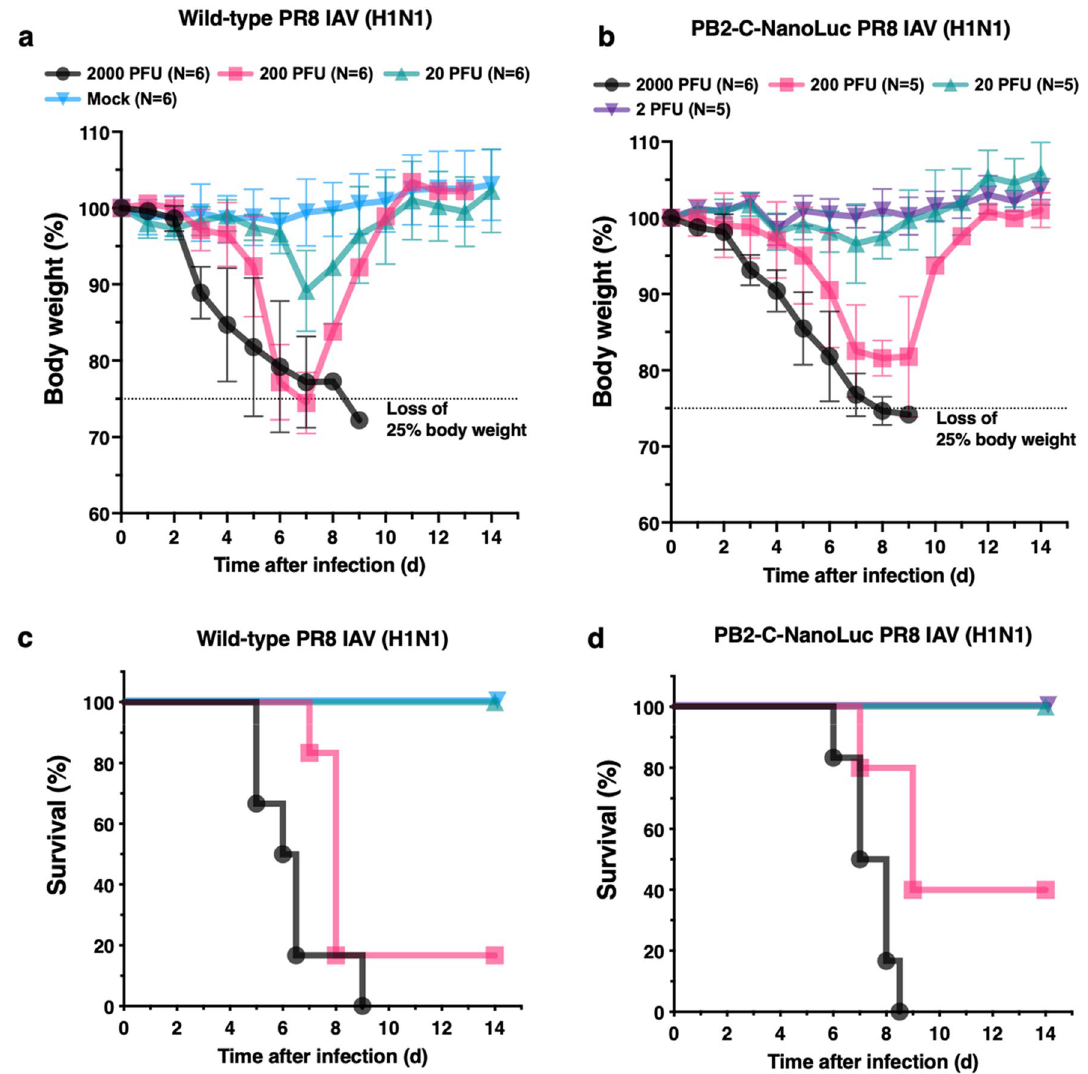
Figure 5. Virulence of wild-type and PB2-C-NanoLuc PR8 IAVs in mice. Female C57BL/6 mice aged 6 to 8 week were infected intranasally with wild-type or PB2-C-NanoLuc PR8 IAV at various doses or no virus (mock) in sterile PBS and observed for 14 days. Body weight reported as percentage of initial body weight (mean ± SD). ( a ) Body weight in cohorts of mice given mock infection or infected with wild-type PR8 IAV. Body weight decreased initially in infected mice but increased after 7 days in mice infected with 20 or 200 PFU of wild-type IAV that survived. ( b ) Body weight change in cohorts of mice infected with PB2-C-NanoLuc PR8 IAV. Body weight decreased initially in infected mice but increased in mice infected with 20 or 200 PFU of PB2-C-NanoLuc IAV that survived beyond 7 to 9 days. ( c ) Survival in mice given mock infection or infected with wild-type PR8 IAV; 5 of 6 mice infected with 200 PFU (83%) died, and all 6 mice infected with 2000 PFU (100%) died within 9 days. The 50% mouse lethal dose (MLD 50 ) of wild-type PR8 IAV was 95 PFU. ( d ) Survival in mice infected with PB2-C-NanoLuc PR8 IAV; 3 of 5 mice infected with 200 PFU (60%) died, and all 6 mice infected with 2000 PFU (100%) died within 8.5 days. The MLD 50 of PB2-C-NanoLuc PR8 IAV was 160 PFU. Log-rank test showed no significant difference between survival curves from wild-type vs PB2-C-NanoLuc IAV at 200 PFU ( p = 0.26) and 2000 PFU ( p = 0.42). Time to loss of 25% of initial body weight was similar between mice challenged with wild-type (200 PFU, 7–8 days post infection; 2000 PFU, 5–9 days post infection) and PB2-C-NanoLuc PR8 IAV (200 PFU, 7–9 days post infection; 2000 PFU, 6–8.5 days post infection). PFU plaque forming during convalescence (Fig. 6c). At 2 PFU, relative flux signals were observed at 2 days after infection and didn’t return to baseline until 9 days post infection, long after body weight had recovered. At 20 PFU, relative flux was also observed as early as 2 days post infection and increased between days 4 and 7 as body weight decreased. Body weight began to increase after 7 days while the relative flux decreased. At 200 PFU, body weight decreased until 9 days after infection. The relative flux at the lung did not increase above 10, but relative flux at the nasal turbinates and trachea increased to > 10 and rapidly decreased to 1 by 9 days after infection, at the beginning of